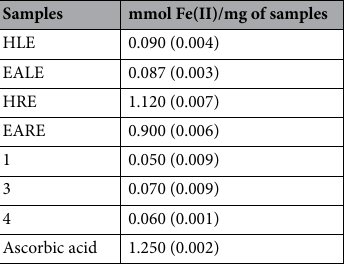
Table 5. Ferric-reducing potential of extracts and isolated compounds of O. cufodontii . Samples were measured in triplicates and expressed as M ± SD; Ascorbic acid was used as positive